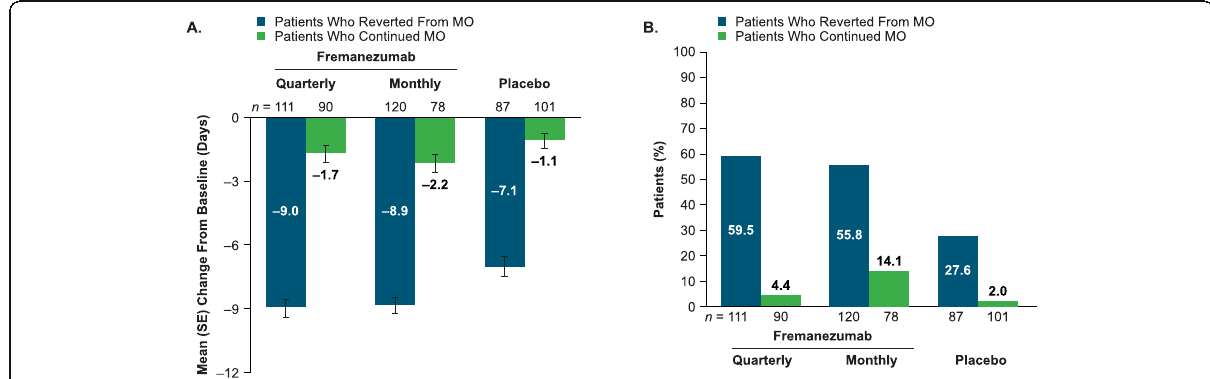
Fig. 4 (a) Reduction in medication use and (b) ≥ 50% response in patients with CM by reversion to no MO. Values shown in part A are mean (SE) change from baseline over 12 weeks in the monthly average number of days of acute medication use in patients who reverted from MO to no MO (blue bars) and in those who did not revert from MO to no MO (green bars). Values shown in part B are the proportions of patients with a ≥ 50% response, defined as a ≥ 50% reduction in the monthly average number of headache days of at least moderate severity from baseline over 12 weeks, in patients who reverted from MO to no MO (blue bars) and in those who did not revert from MO to no MO (green bars). CM = chronic migraine; MO = medication overuse; SE = standard